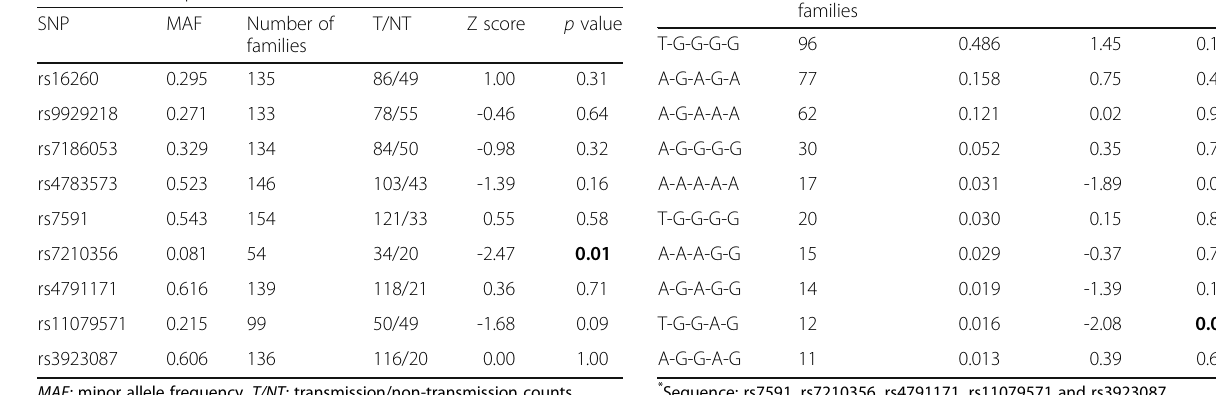
Table 2 Transmission disequilibrium test (TDT) of the single- nucleotide polymorphisms (SNPs) in nonsyndromic cleft lip with or without cleft palate (NSCL ± P) trios